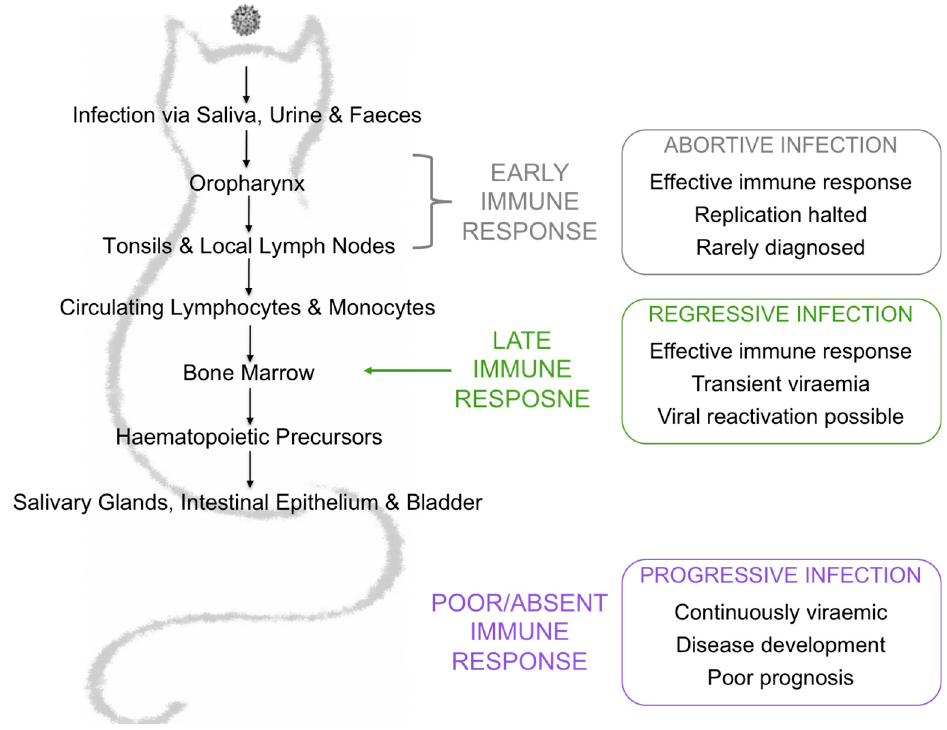
Figure 1. Exposure outcomes are largely influenced by the immune response to infection. Abortive infection is the result of a low dose exposure to FeLV or an effective and specific immune response early in infection. Regressive infection is the result of an effective immune response later in infection, either just before or just after bone marrow infiltration. Cats with regressive infection are transiently antigenaemic and viraemic. After weeks to months, the viraemia is controlled and these cats become aviraemic. Progressive infection is the result of a poor immune response. Cats with progressive infection are continuously viraemic and have a poor prognosis, developing FeLV-associated diseases and usually have a limited lifespan.